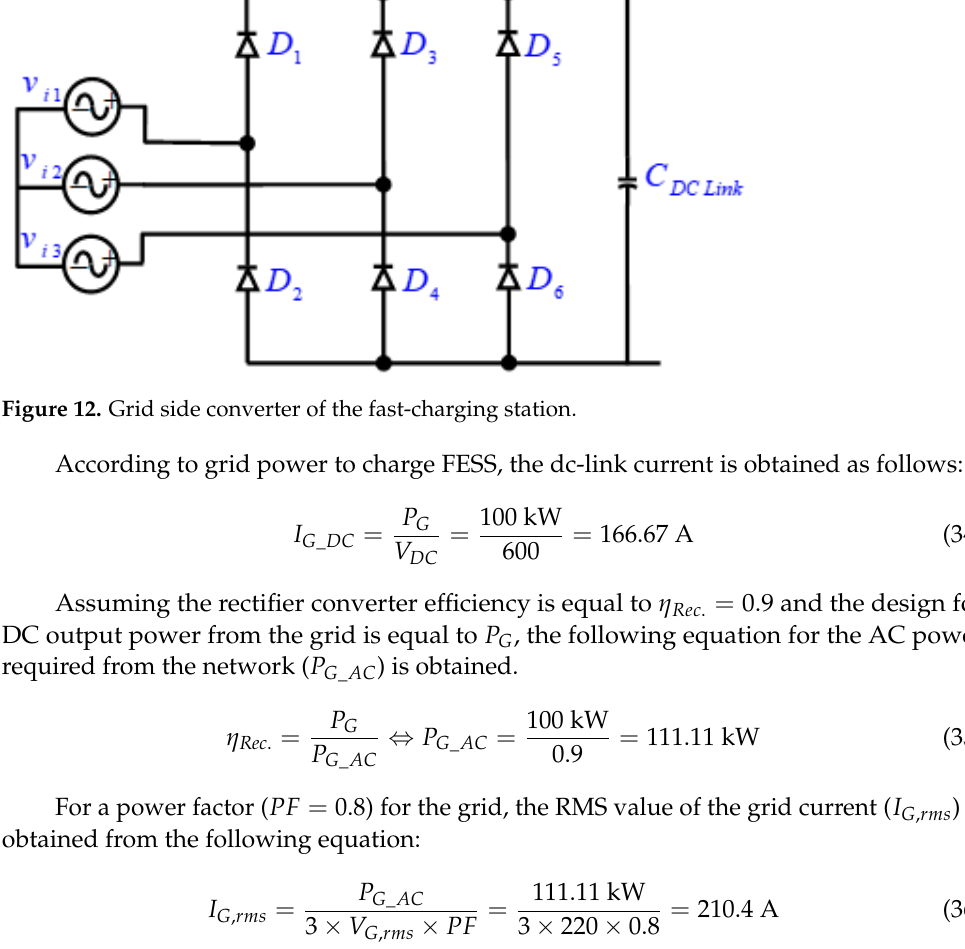
12 of 24 Figure 11. The maximum mechanical stress of the flywheel disk. Table 3. The geometrical dimensions of the designed flywheel disk. Diomension